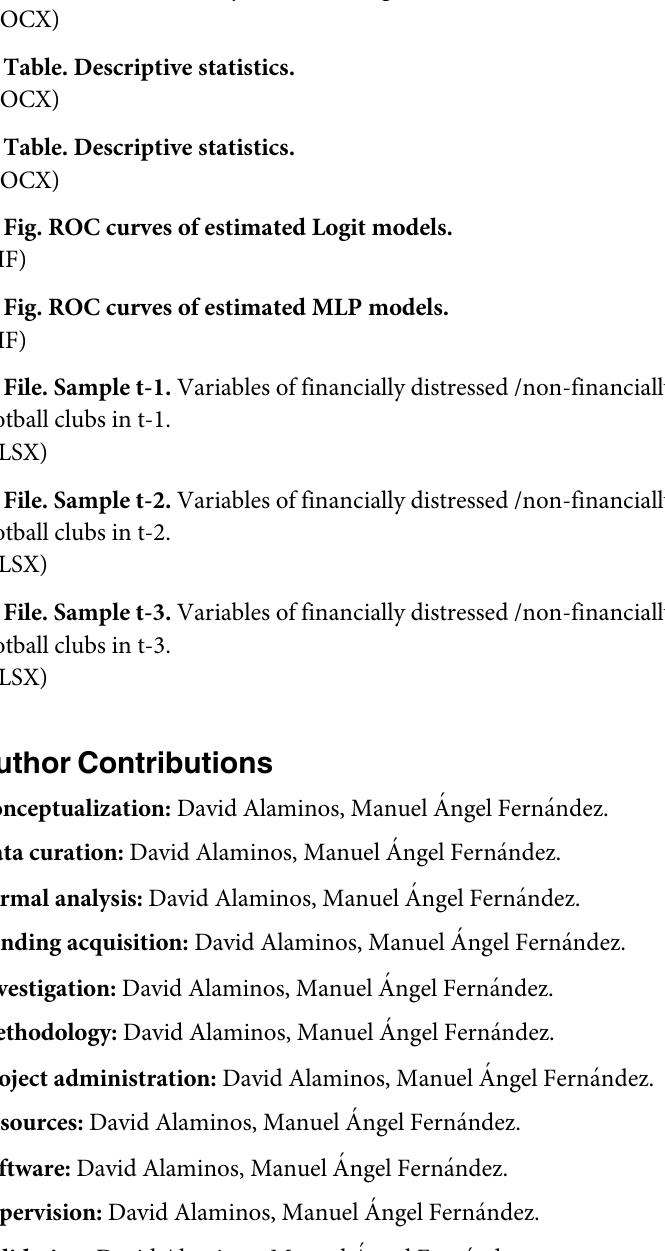
S1 Table. Observations by National League. S2 Table. Descriptive statistics. S3 Table. Descriptive statistics. S1 Fig. ROC curves of estimated Logit models. S2 Fig. ROC curves of estimated MLP